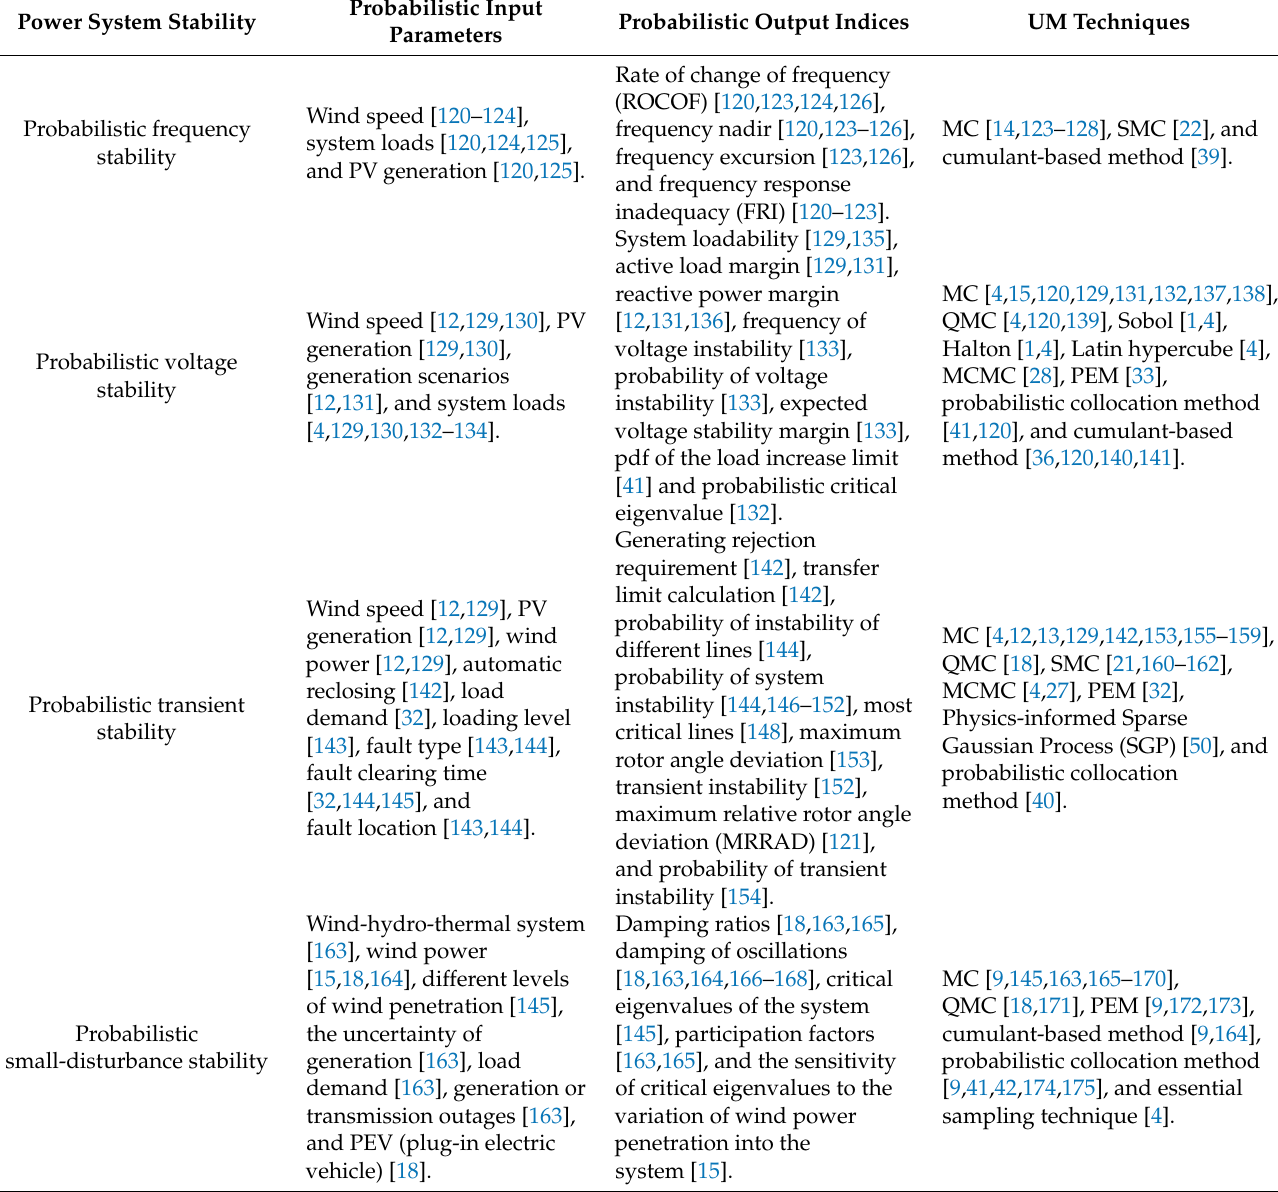
Table 2. The probabilistic input parameters, output indices, and UM techniques and their applications in power system stability